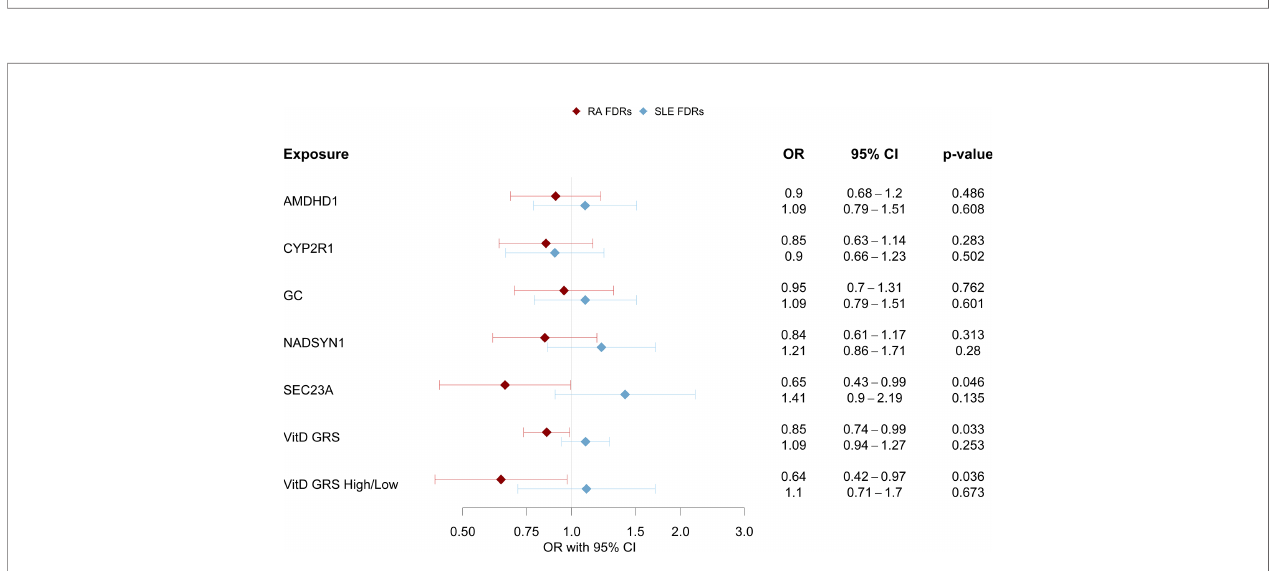
FIGURE 1 | Effect allele frequencies and vitamin D GRS distribution. Effect alleles are those that were associated with an increased 25(OH)D. (A) The allele frequency for each of the 5 SNPs used in the vitamin D GRS calculation are shown. The SLE FDRs are shown in white bars (LFRR cohort) and RA FDRs are in gray bars (SERA cohort). (B) The distribution of the vitamin D GRS is shown in for each